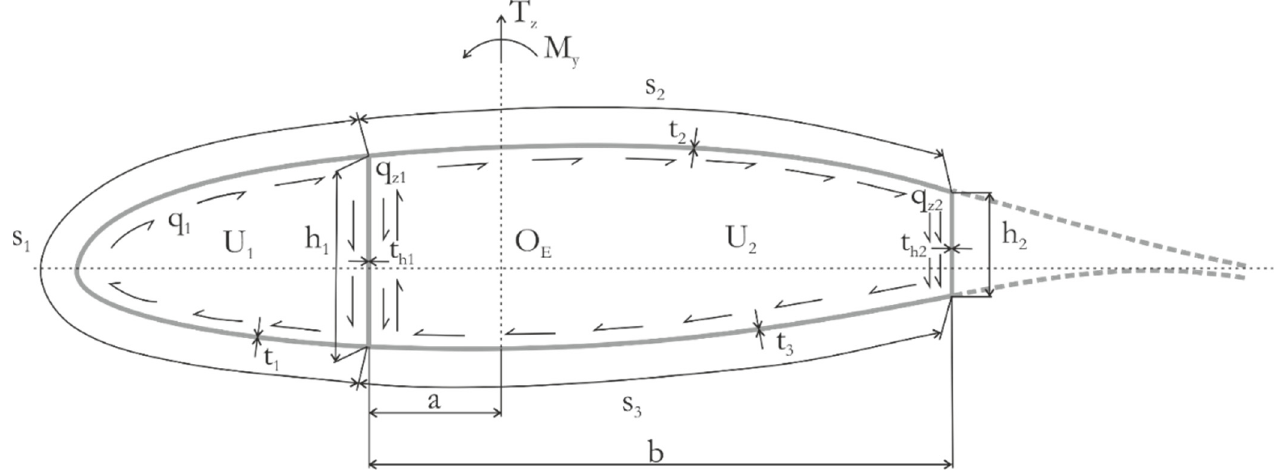
Figure 9. Double spars wing with two cells. This picture serves for shear stress calculation. Sheer fluxes of skin are labeled by q , fluxes of spars q z , U describes surface of cell and t is thickness of skin or web.